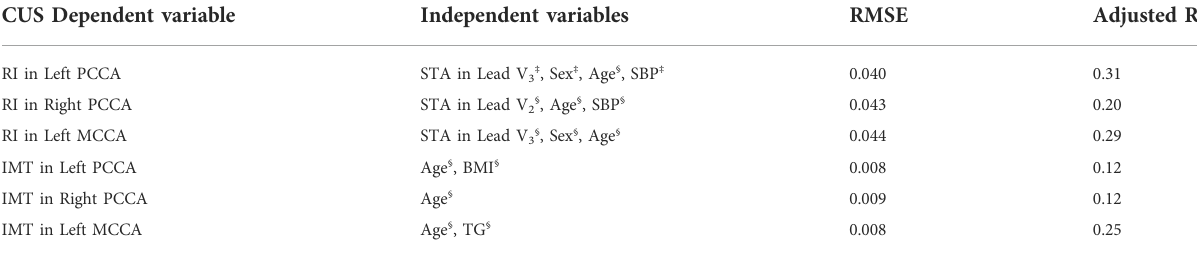
TABLE 5 Stepwise Multivariable regression models for predicting CUS parameters with ECG parameters and CVD risk factors as independent variables. CUS Dependent